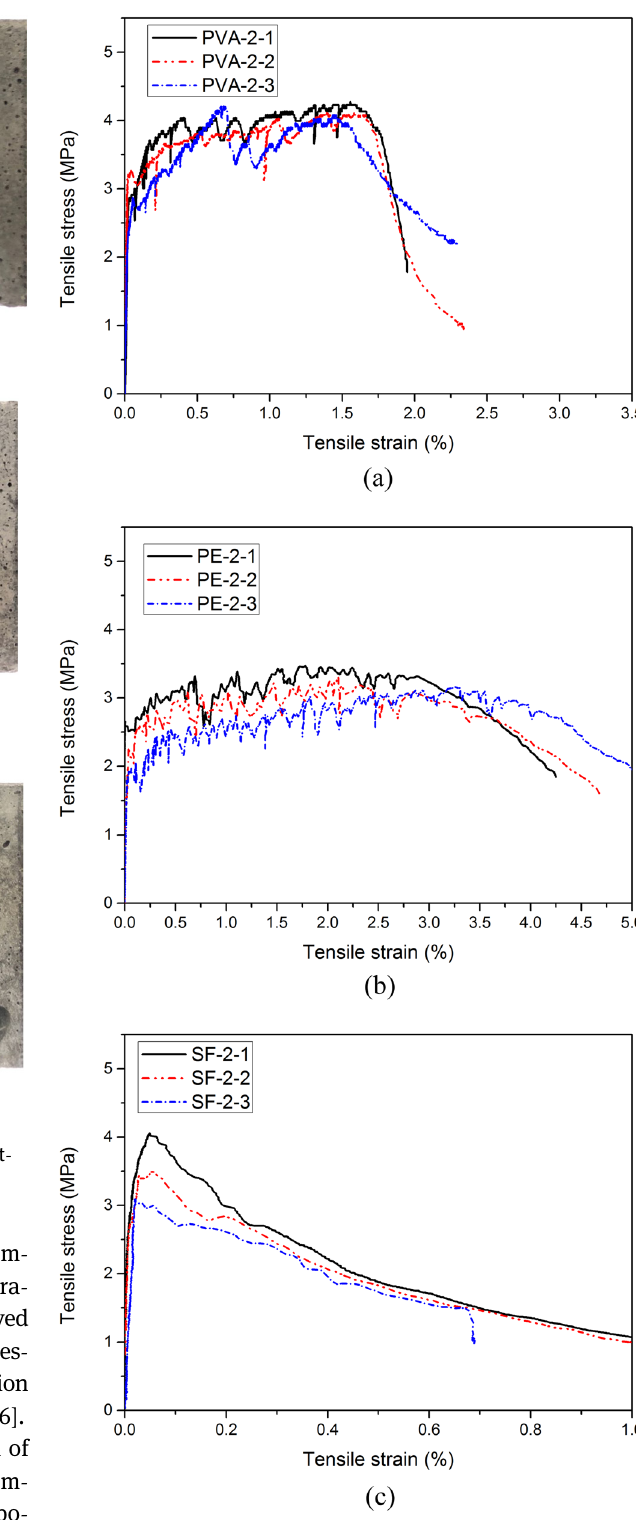
Figure 11: The uniaxial tensile stress – strain curves of lightweight cement - based composites: ( a ) PVA - 2 [ 20 ] , ( b ) PE - 2, and ( c ) SF -